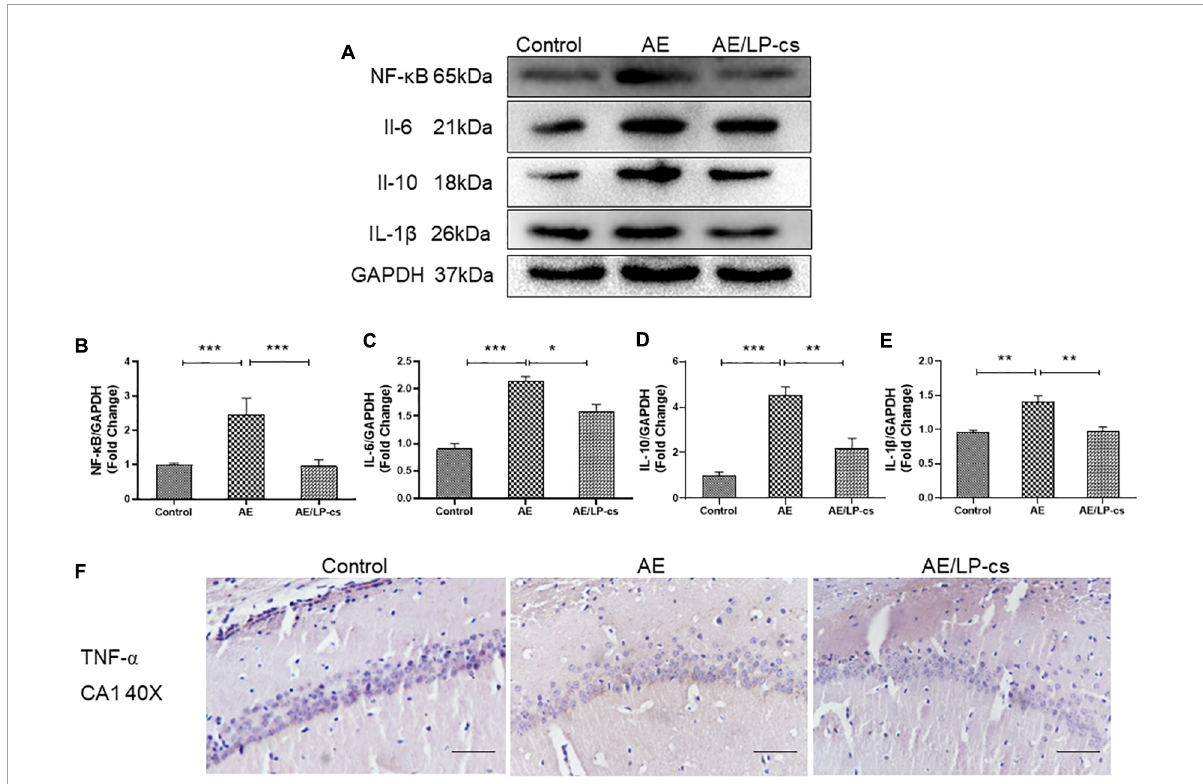
FIGURE7 Lactobacillus plantarum culture supernatants alleviates alcohol-induced inflammation. (A–E) Western blot and quantitative analysis of NF- κ B, IL-1 β , IL-6, and IL-10, n = 5–10. (F) The immunohistochemical staining of TNF- α in the CA1 of the hippocampus (scale bar, 15 µ m, n = 3–6). Control vs. AE and AE vs. AE/LP-cs, * p < 0.05, ** p < 0.01, *** p <